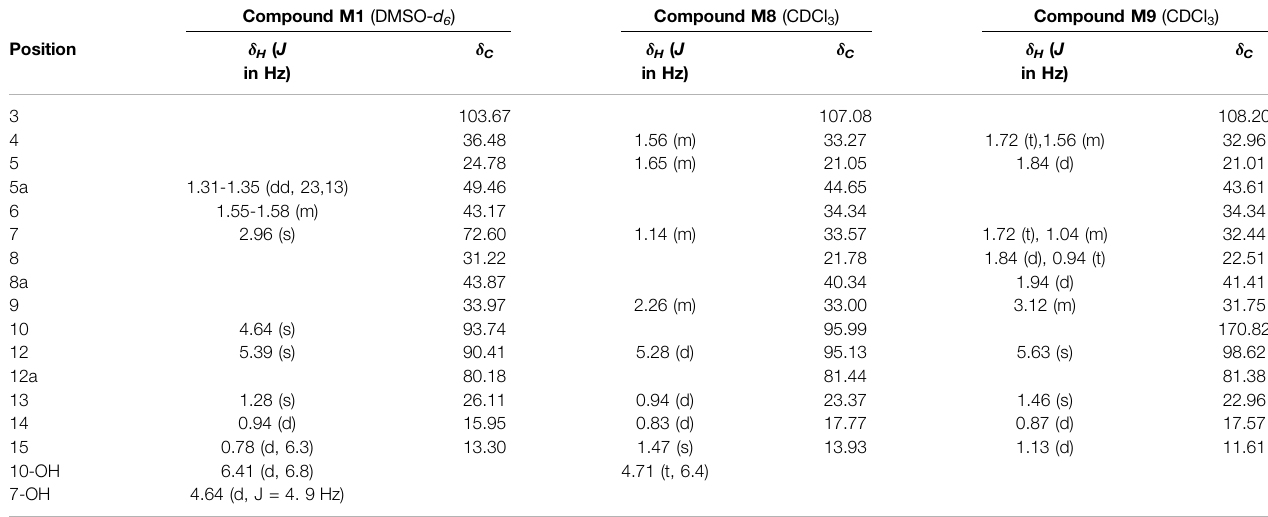
TABLE 2 | 1 H NMR (600 MHz) and 13 C NMR (150 MHz) data of three compounds ( δ : ppm).